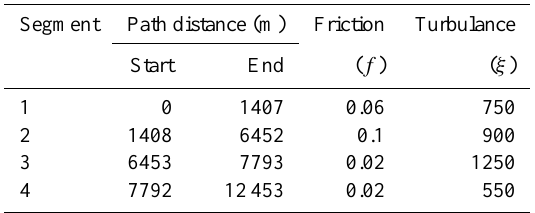
Table 3. Friction and turbulence parameters along path segments used in DAN-W.